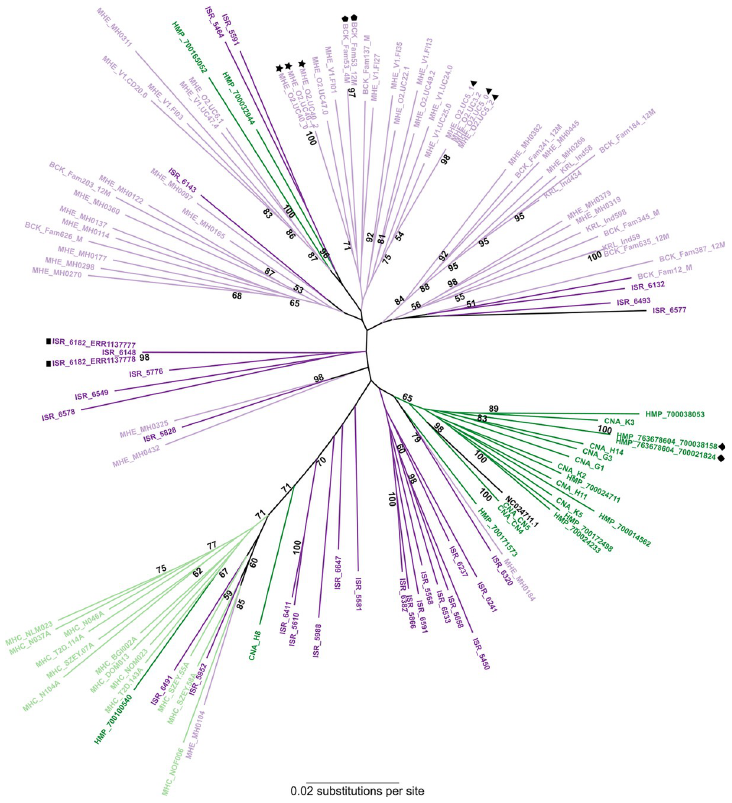
Fig 1. Phylogenomic analysis of crAssphage strains. The Maximum Likelihood tree was based on a multi-genome alignment comprising 97,065 sites. The tree was built using the Generalized Time-Reversible model with gamma- distributed rate variation and proportion of invariant sites. Bootstrap support was estimated from 100 replicates; only values greater than 50% are shown. Strains are color-coded according to the geographic location: dark green–The Americas, light green–Asia, light violet–Europe, and dark purple–Middle East (Israel). Symbols are used to denote strains from the same individual.